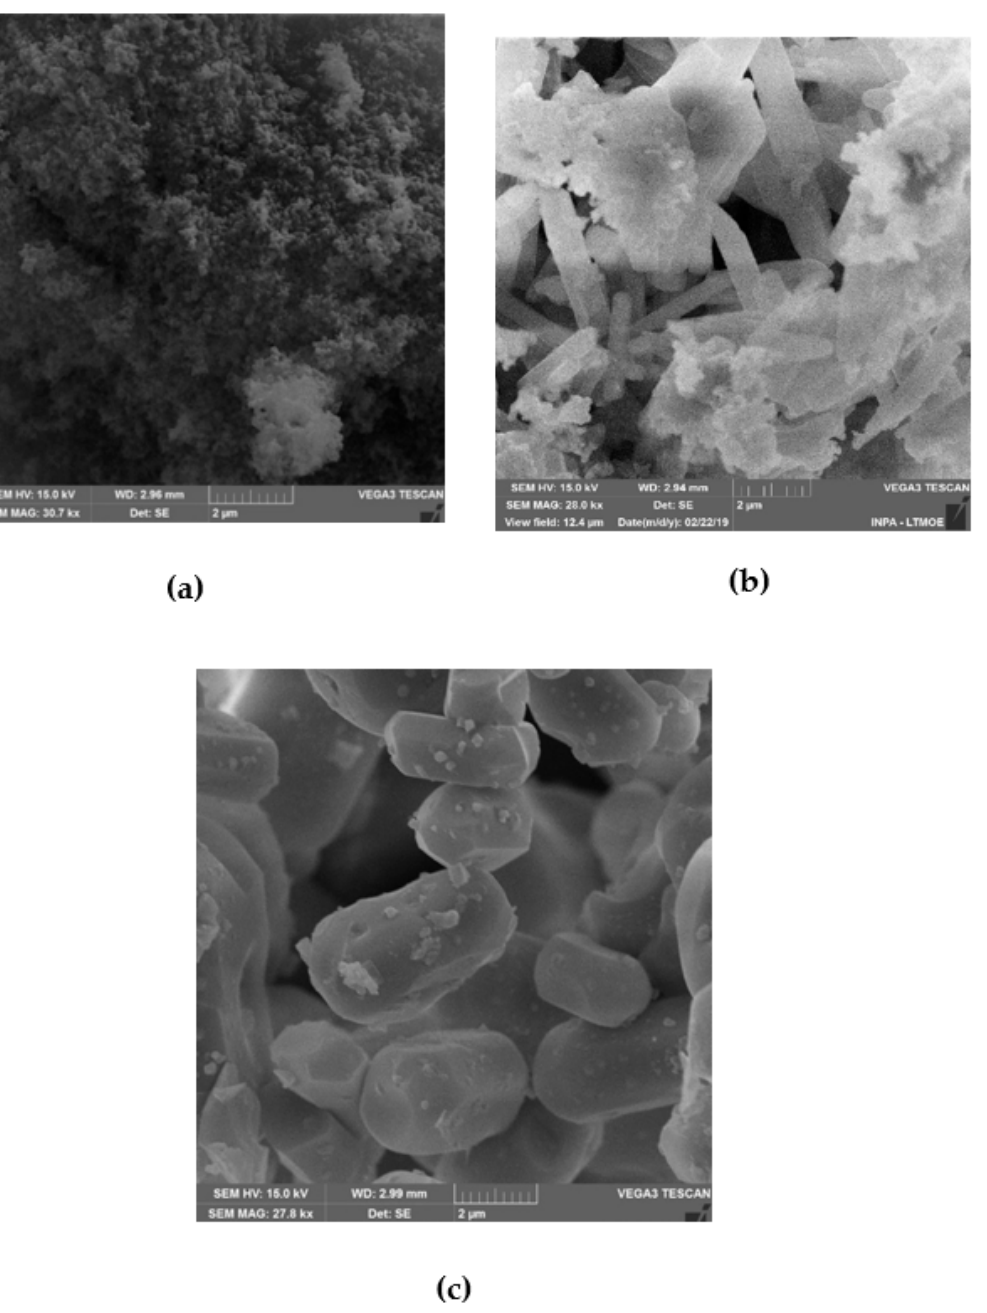
Figure 6. SEM images of chlorapatite calcined at different temperature: ( a ) 600 °C (ClAp600); ( b ) 800 °C (ClAp800); and ( c ) 1000 °C (ClAp1000).